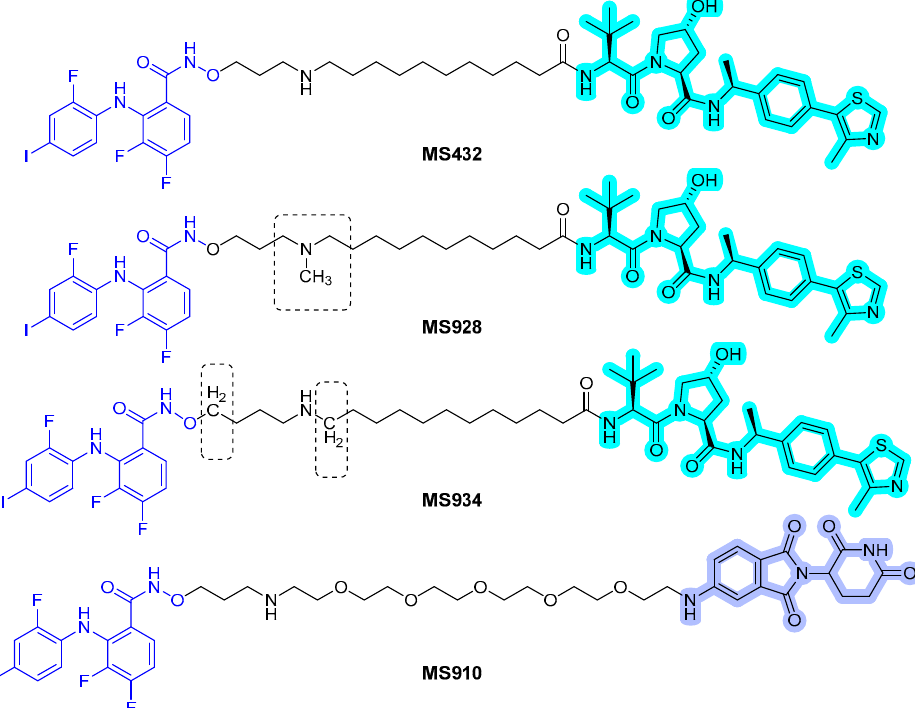
Figure 10. MEK1/2 degraders. The dashed boxes in MS928 and MS934 indicate the part of each compound that differs in structure from MS432. The colors show the part of each compound that is a structurally important binding motif. The ligands of the POI are in blue. VHL and CRBN ligands are highlighted in cyan and purple, respectively.